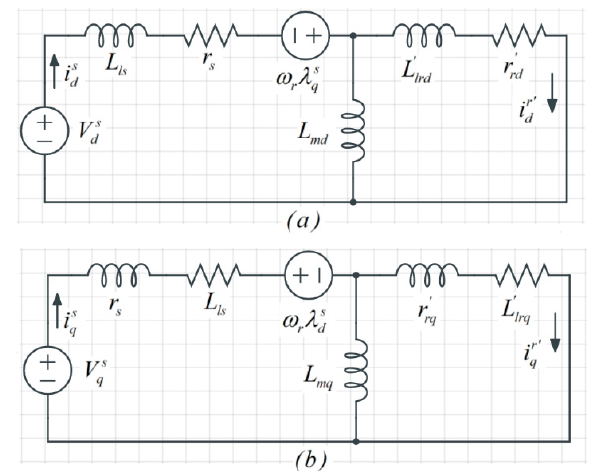
Figure 1. LSPMSM dynamic equivalent circuits ( a ) d-axis circuit ( b ), q-axis circuit.